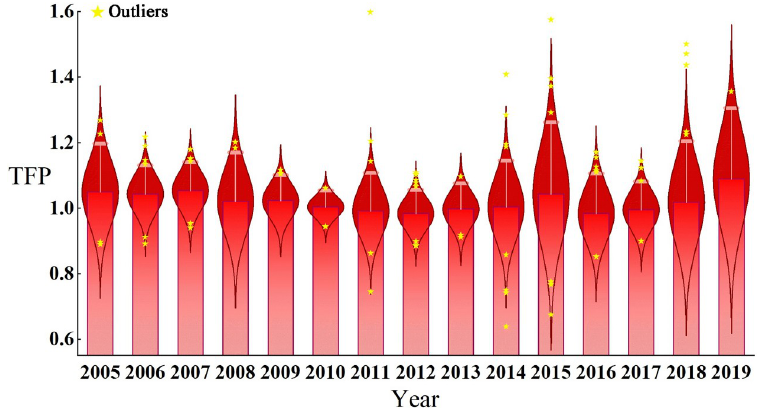
Fig 2. Changes in TFP for urban economic development and changes in decomposition indicators in